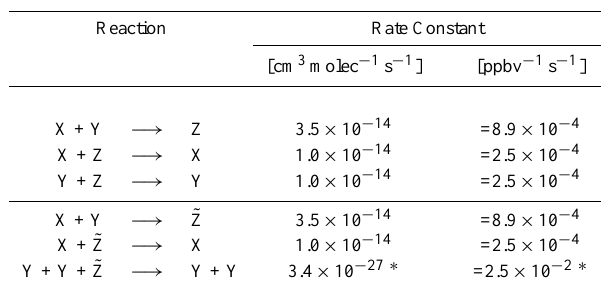
Table 2. Information on chosen reaction rates for the two chemical reaction systems.